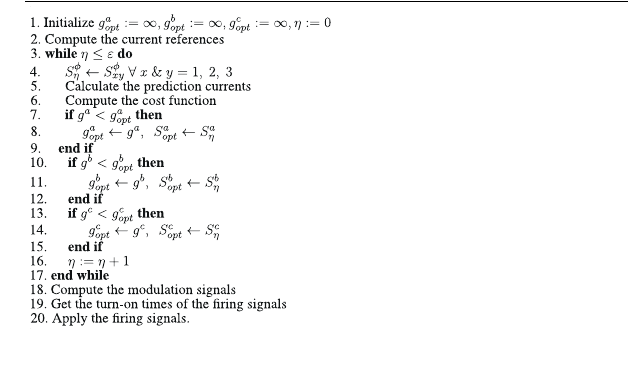
Algorithm 1. Optimization algorithm of the proposed modulated MPC current controller.